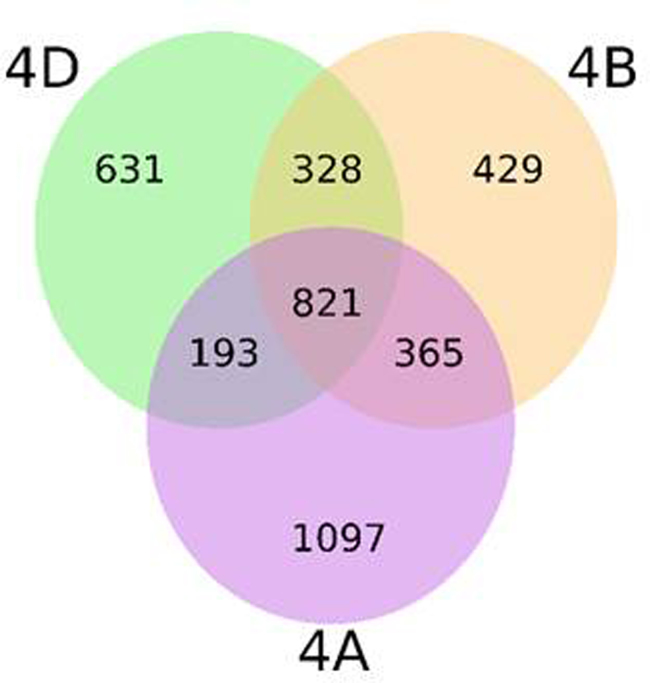
Venn diagram displaying the number of syntenic genes shared by wheat chromosomes 4A/4B, 4A/4D and 4B/4D and the three ways intersect.